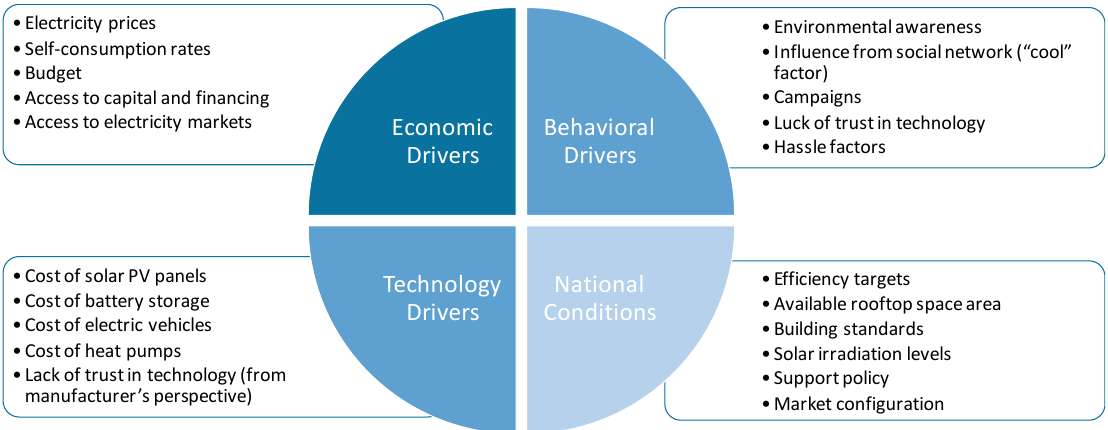
Figure 11. Drivers influencing the penetration of solar PV panels in single- and two-family houses.